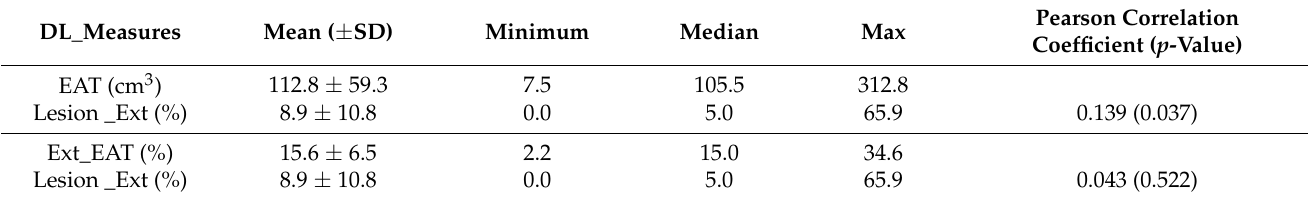
Table 3. Correlation between lung lesions extent and epicardial adipose tissue volume and epicardial adipose tissue extent (n = 238). EAT: epicardial adipose tissue volume (cm 3 ); Lesion_Ext: COVID-19